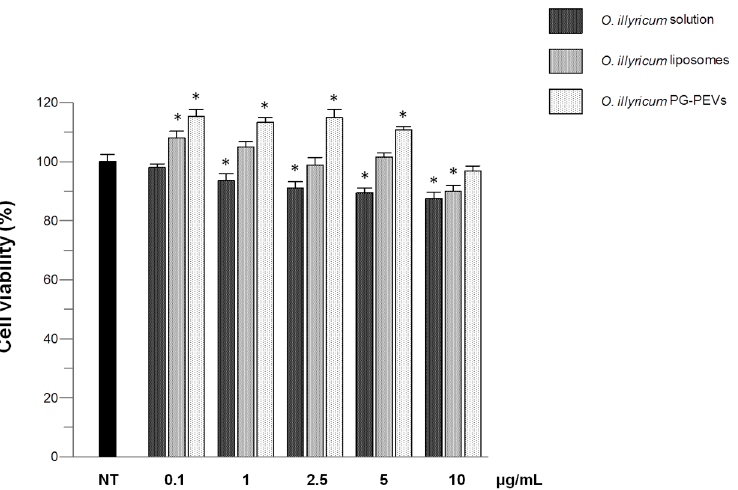
Figure 2. Effect of O. illyricum solution and O. illyricum liposomes/PG-PEVs on HaCaT cell viability. After 24 h of incubation with samples at different concentrations (0.1–10 μ g/mL), cell viability was determined by the MTT assay. Asterisks indicate the statistical differences ( p < 0.01) vs. non-treated control cells (NT). At each concentration, the three samples were also statistically different ( p < 0.001) from each other, with the exception of O. illyricum solution vs. O. illyricum liposomes at 10 μ g/mL. In addition, ROS levels in cells were evaluated before and after H 2 O 2 -induced oxida- PEVs. H 2 O 2 -generated ROS in the cytoplasm oxidate DCFH to fluorescent DCF, whose